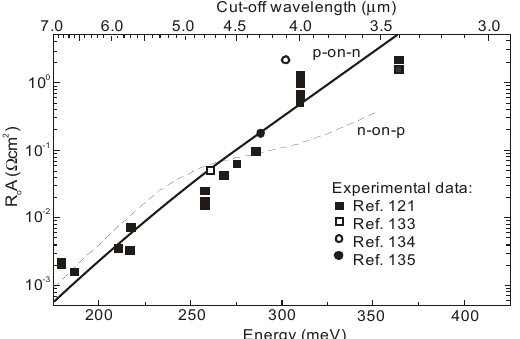
Figure 42. The R o A product versus λ cut-off for InAs 1–x Sb x p-on-n and n-on-p photodiodes at room temperature. The theoretical lines are calculated for doping concentration of 10 16 cm − 3 in both p- and n-type 5- µ m thick absorber. The gathered experimental data concerns p-on-n photodiodes with n-type active region (after [91]).